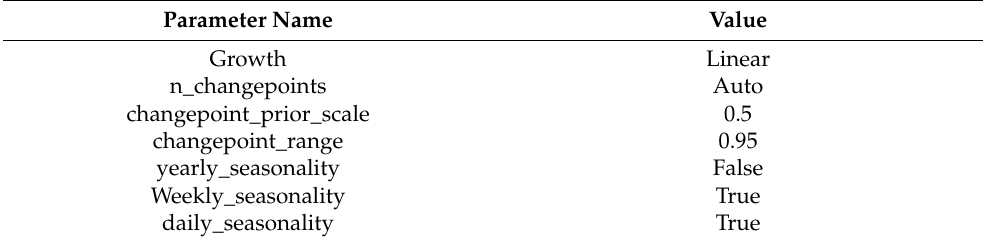
Table 2. Prophet parameter